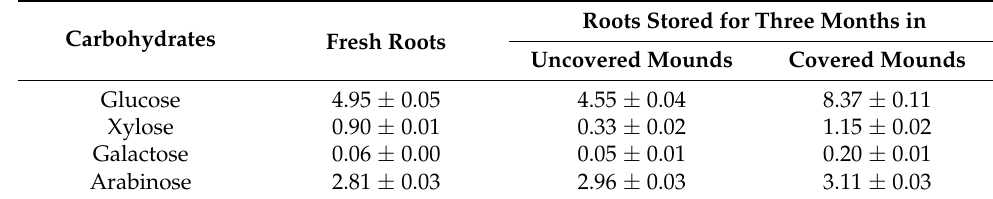
Table 2. The content of carbohydrates after the hydrolysis of complex carbohydrates in sugar beet roots (% w / w ).